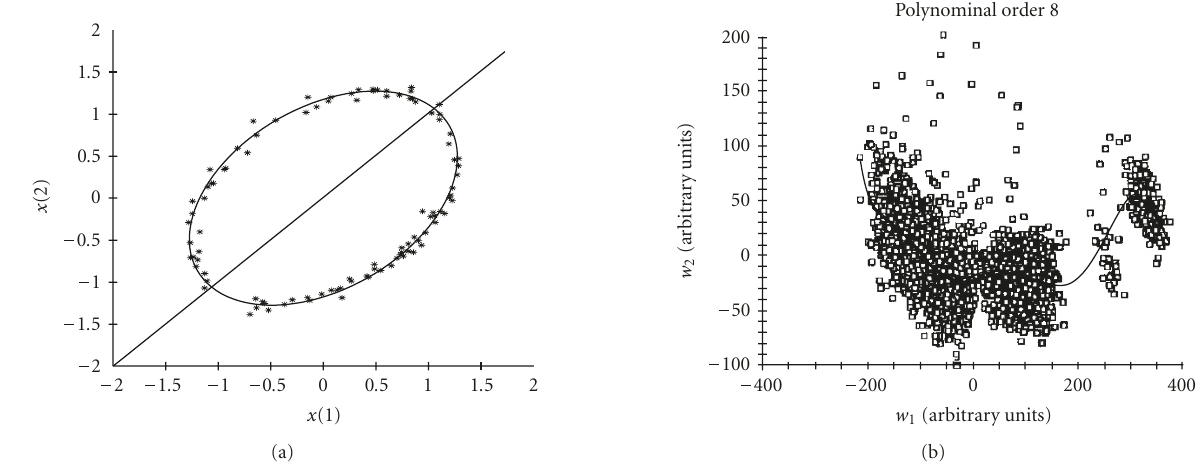
Figure 5: (a) Plot of the two-sample data x (1) and x (2) generated by the hidden factor φ , see text, with Gaussian white noise added. The straight line represents the first eigenvector that results from PCA, whereas the circle represents the parametric curve that results from nonlinear PCA. It is clear that the projection error on the straight line is much larger than on the elliptic curve, and therefore nonlinear PCA has a superior concentration capability in this particular example. (b) An example of a nonlinear function (polynomial) capturing the dependency between the two largest principal components. (Reprinted from [22] with